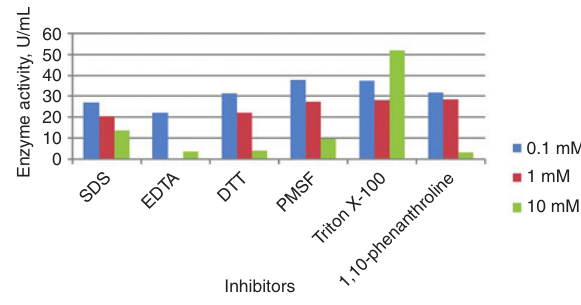
Figure 7: Effect of inhibitors on pterin deaminase activity.